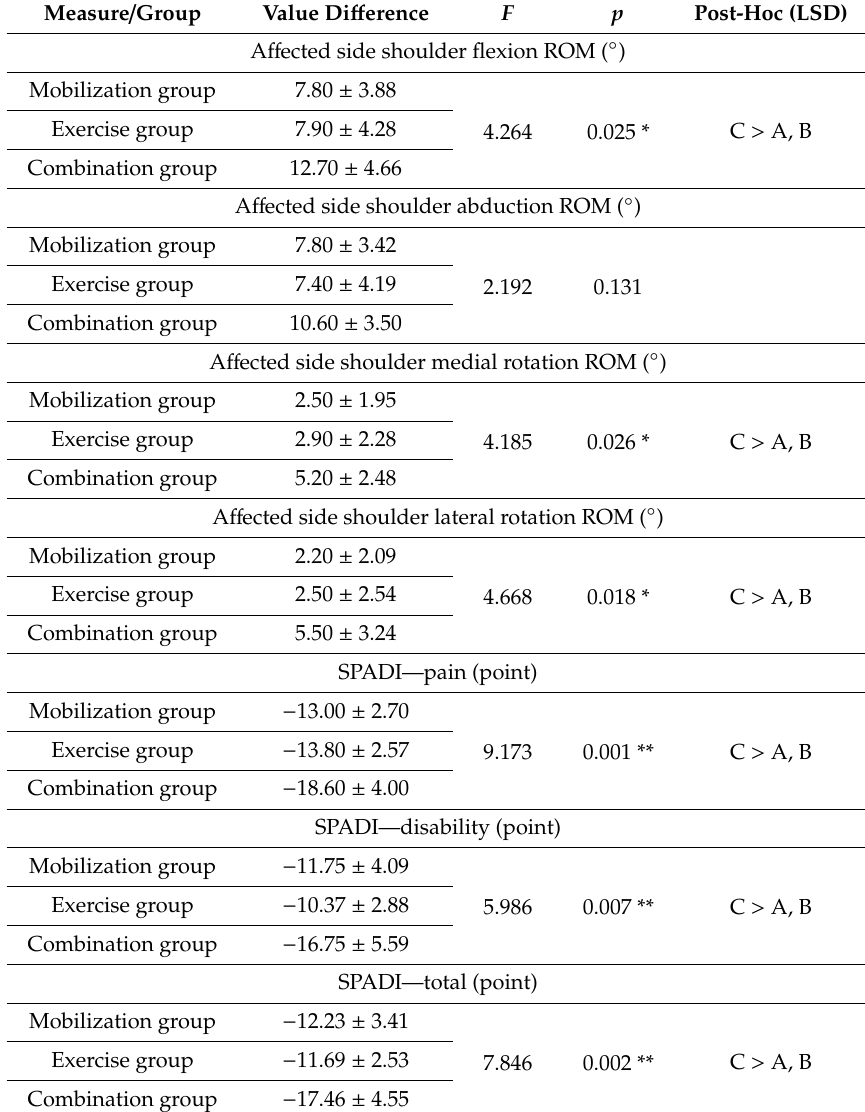
Table 5. Comparison of the a ff ected side shoulder ROM and SPADI point in three intervention groups. Measure /